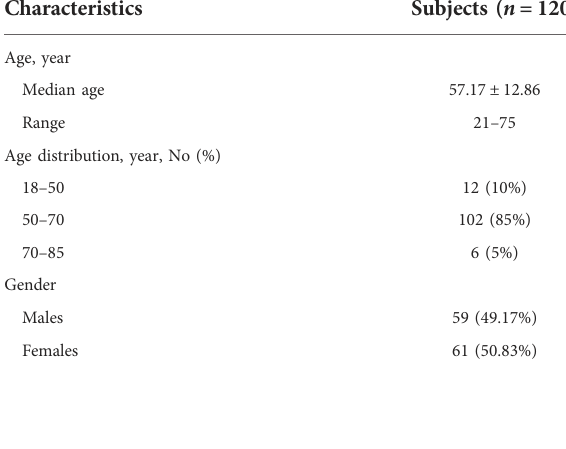
TABLE 1 Demographic characteristics of the